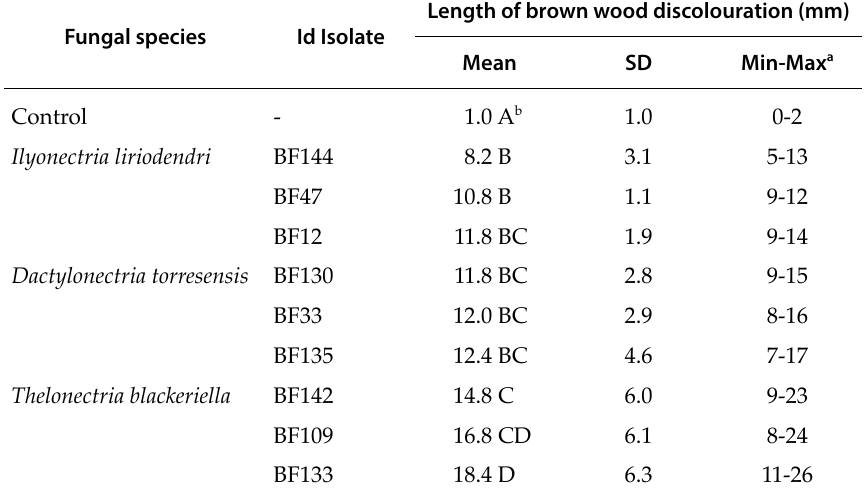
a Minimum and maximum values detected, (12 observations). b Data followed by different capital letters within the column are significantly different (Fischer’s tests; P